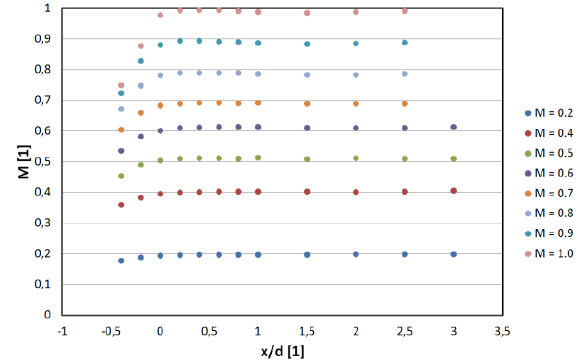
Fig. 6. Mach number distribution in the nozzle centreline determined from the static pressure